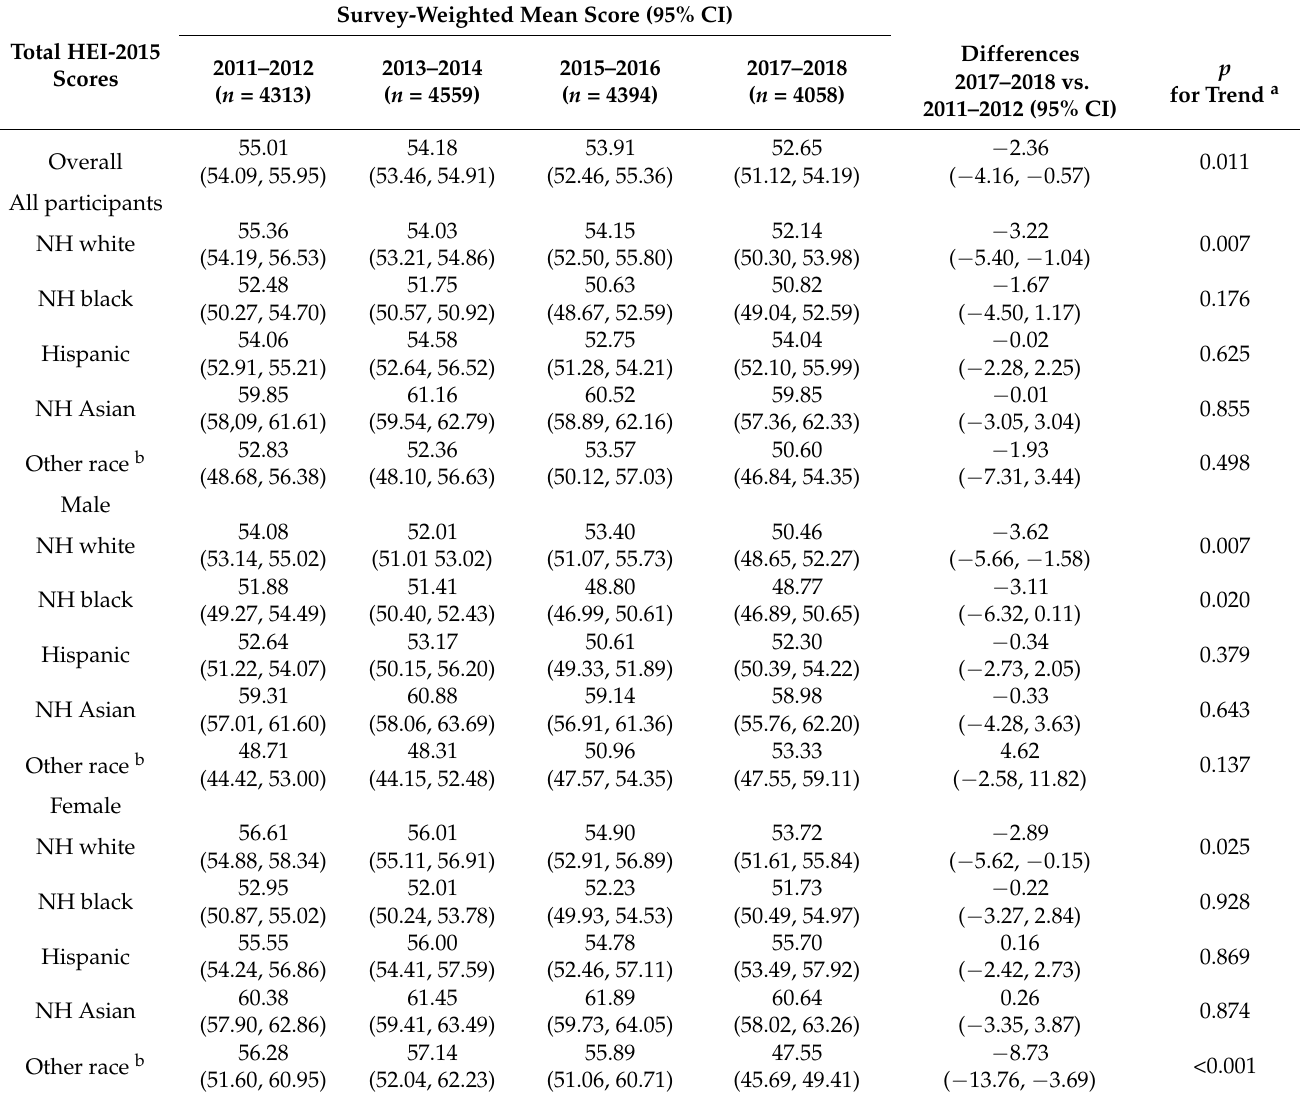
Table 1. Trends in estimated HEI-2015 score among adults aged ≥ 20 years by race/ethnicity and sex, NHANES, 2011–2018